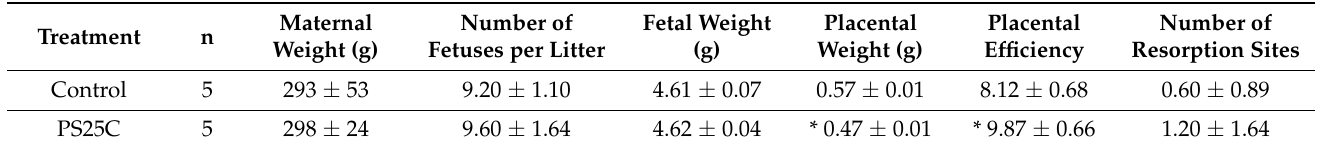
Table 1. Effect of maternal ingestion exposure to 25 nm carboxylate-modified polystyrene (PS25C) on maternal, placental and litter